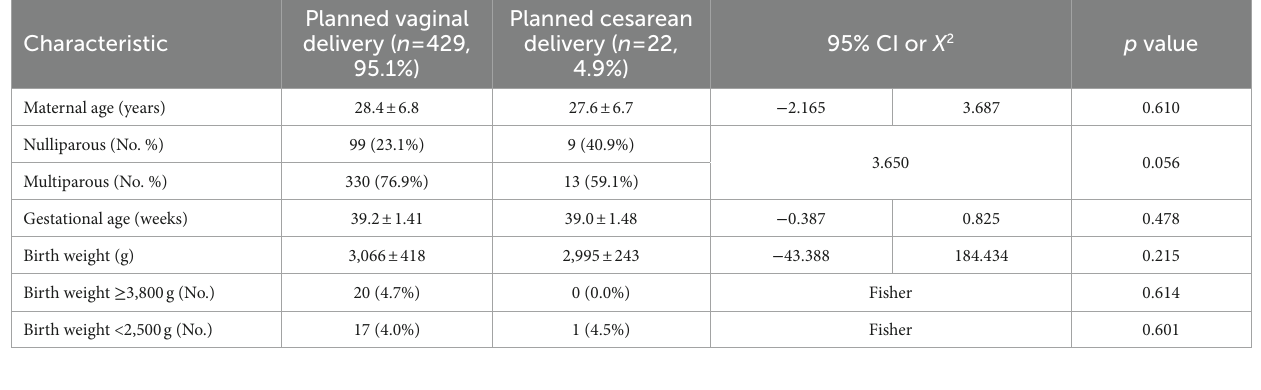
TABLE 1 Characteristics of term breech delivery in the study.